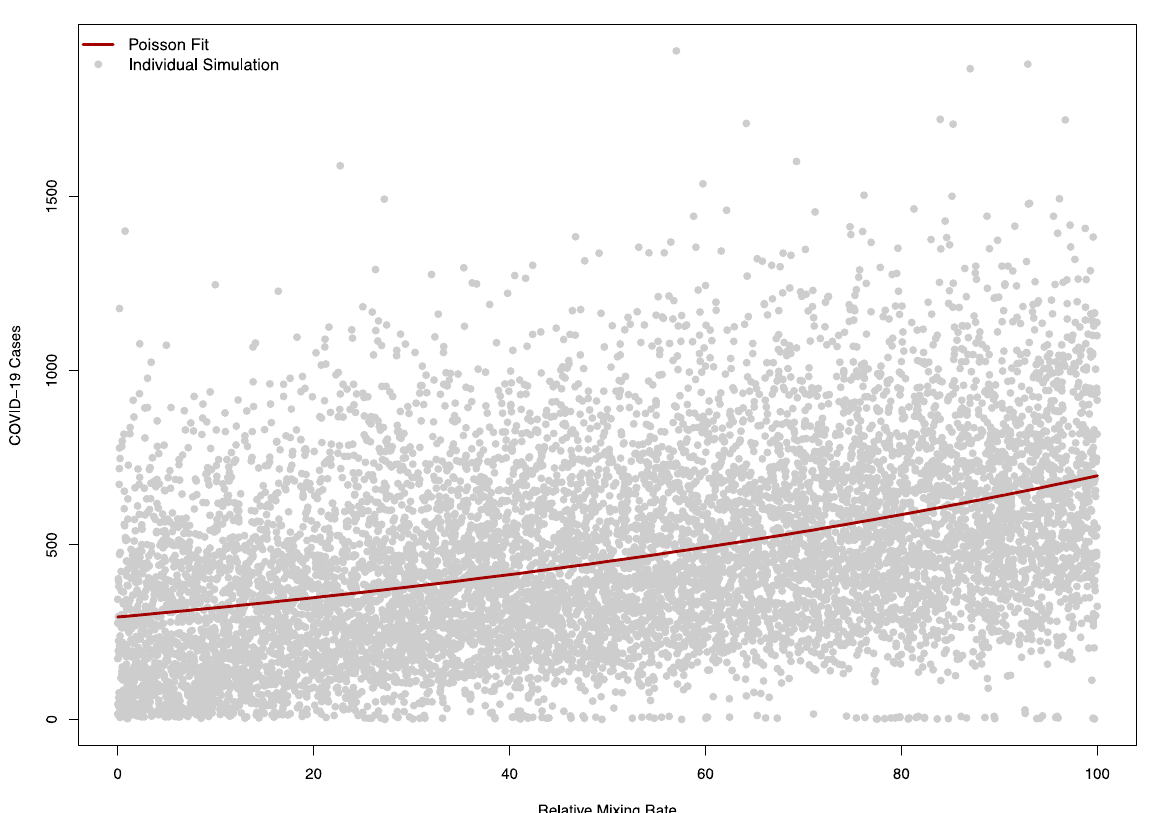
Figure 8. Model sensitivity to the relative mixing rate between campus community and visitors in a model ( β F ). A value of zero corresponds to no mixing between the campus and visitors, while 100 corresponds to a level of mixing equal to the campus-campus mixing rate pre-COVID. The solid red line indicates a Poisson regression fit of simulated COVID-19 cases, while each grey dot corresponds to a single simulation.